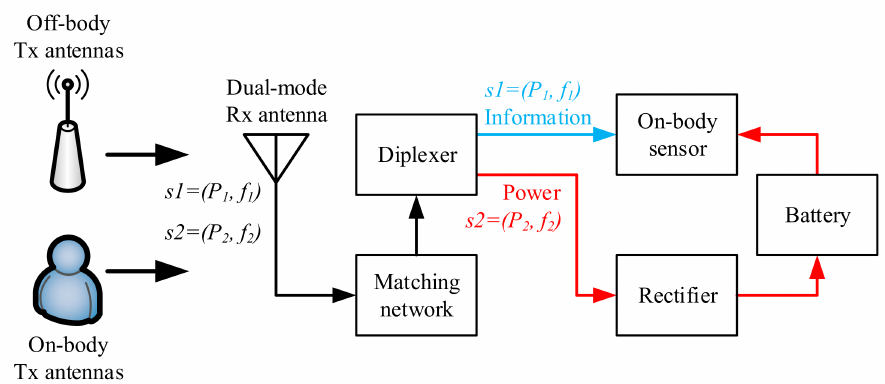
Figure 2. Proposed dual-mode wireless information and power transfer implementation involving two